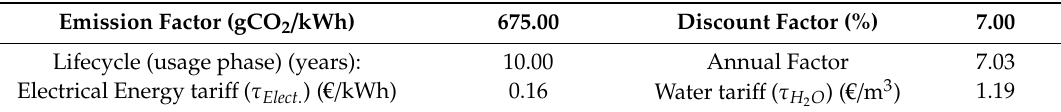
Table 1. Emission factor and other assumptions considered in this work.